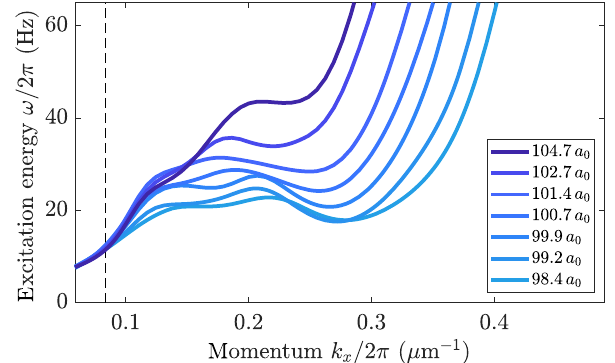
FIG. 3. Experimentally determined excitation energy ω ð k x Þ according to Eq. (1) assuming a temperature of 20 nK, for scattering lengths above the phase transition point. A clear roton minimum at finite momentum is observed that softens toward the transition